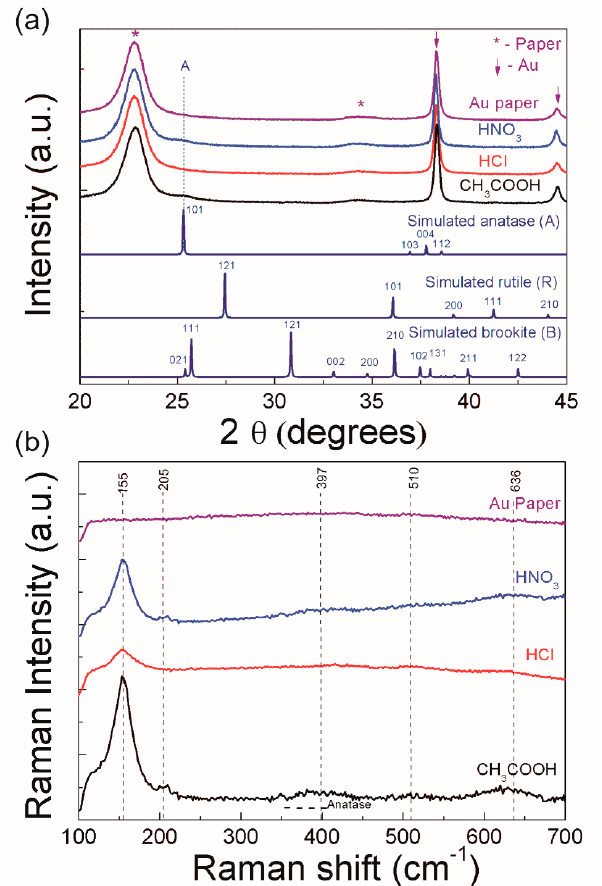
Figure 4. ( a ) XRD diffractograms of the TiO 2 nanostructured films grown on Au paper together with the pristine Au paper. For comparison, the simulated XRD diffractograms of rutile, brookite and anatase are presented. ( b ) Raman spectra of the nanostructured films and the pristine Au paper. Dashed lines indicate the anatase bands.